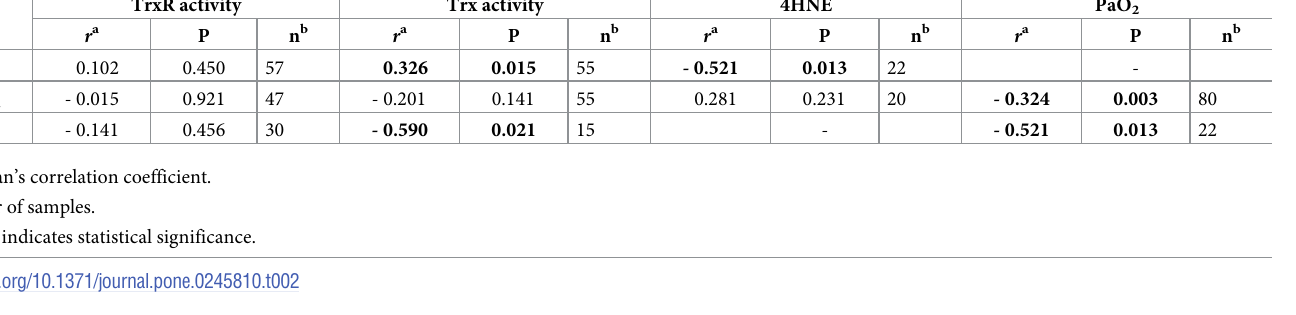
Table 2. Correlations of serum 4HNE, serum TrxR/Trx activities, PaO 2 and PaCO 2 in AECOPD patients. TrxR